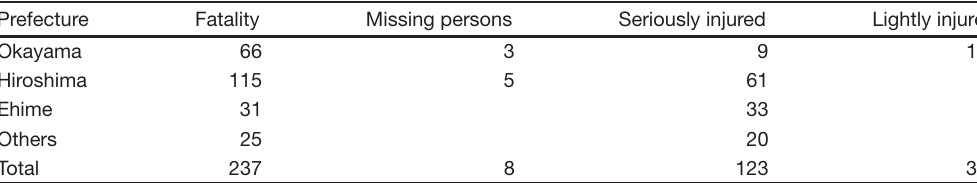
Table 1. Human casualties (as of 9 January 2019)